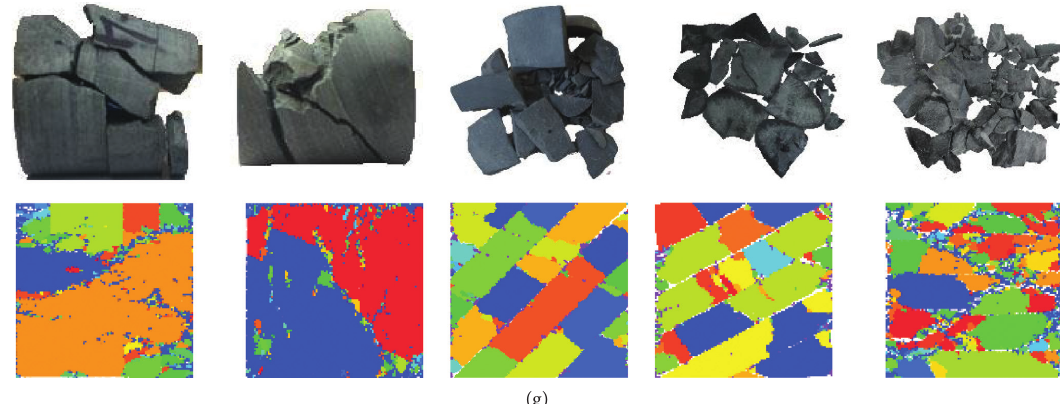
Figure 7: SHPB numerical model and simulation results. (a) Numerical and experimental incident stress wave of 45 ° sample. (b–f) Numerical and experimental dynamic compression stress of five angle samples. (g) The ultimate fragment state of five angle samples after experiment and